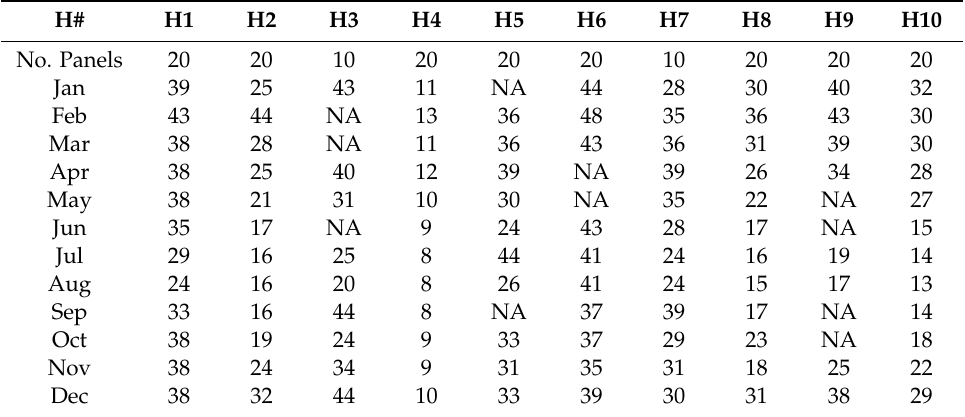
Table 6. Self-su ffi ciency: percentage (%) of energy o ff set by PV consumption.